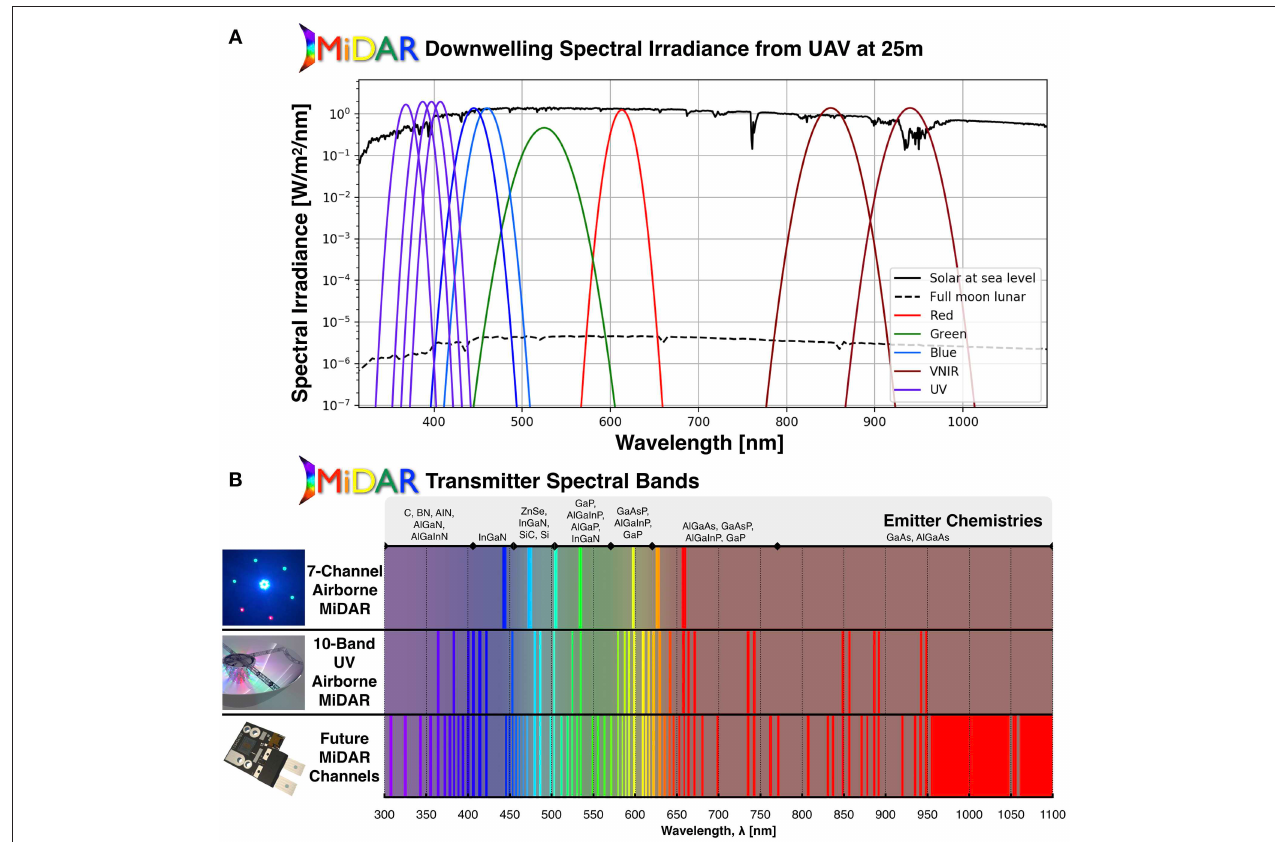
FIGURE 9 | MiDAR power and spectral coverage. (A) MiDAR can operate with zero ambient illumination, but also in the presence of ambient light. A 10-band kw-class airborne MiDAR system is under development that matches or exceeds the solar downwelling irradiance from a UAV at 25m altitude. Typically, MiDAR is used exclusively at twilight and night for maximum SNR, in which case the SNR typically exceeds that of passive instruments by orders of magnitude. (B) Multiple MiDAR transmitters have been developed or are presently under development that span the UV-NIR optical spectrum. Emitter chemistries have been identified for each spectral channel that allow for high luminous